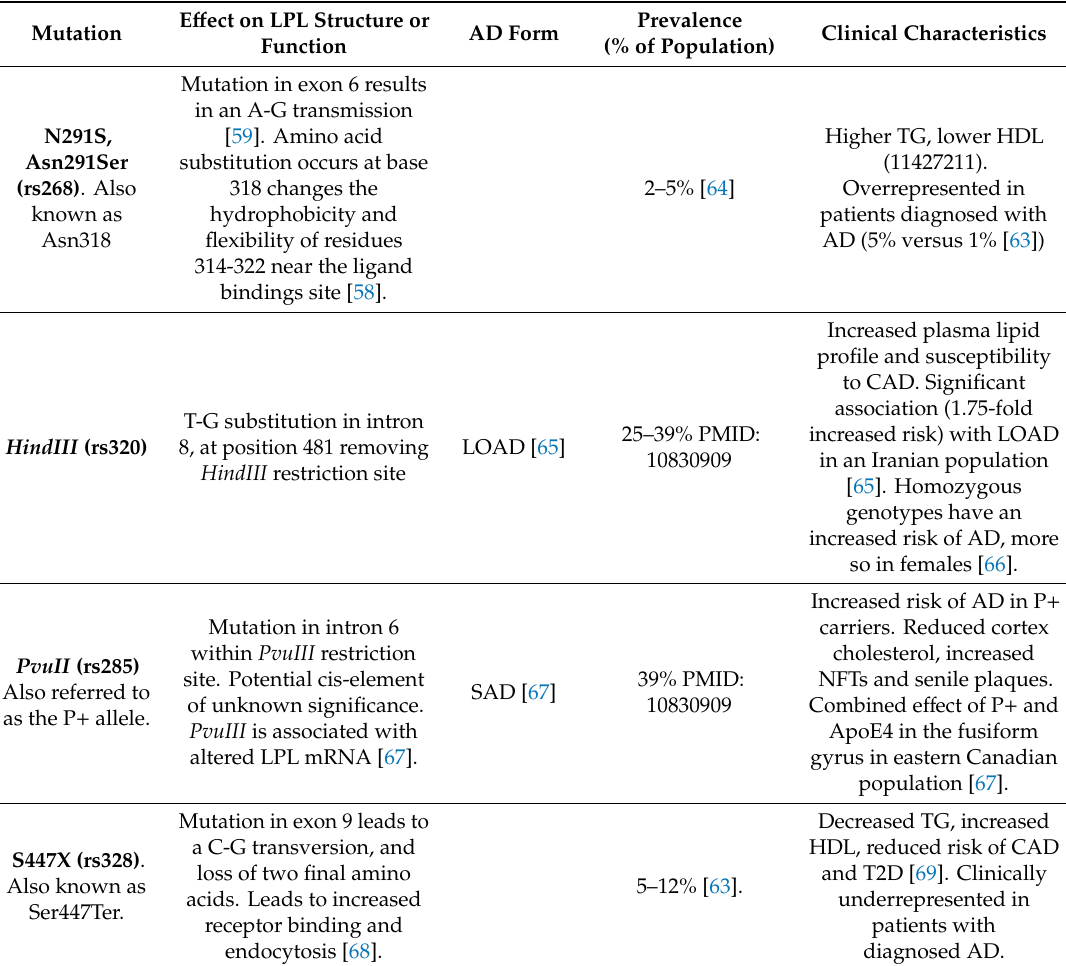
Table 1. Functional and Clinical Characteristics of LPL Variants Associated with AD